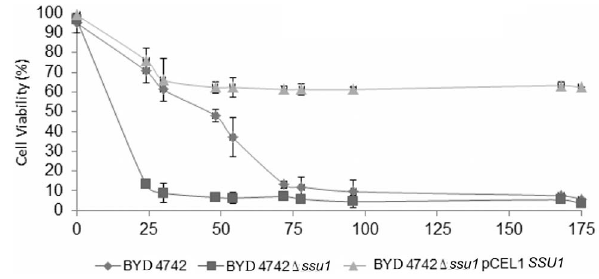
Figure 9. Viability percentage of S. cerevisiae BYD4742 ( ¤ ), BYD4742 D ssu1 ( & ) and BYD4742 D ssu1 pCEL13 SSU1 ( m ) strain during the induction of the VBNC state. Viability percentage is determined by FCM using FDA. Error bars indicate the standard deviation of three independent experiments.